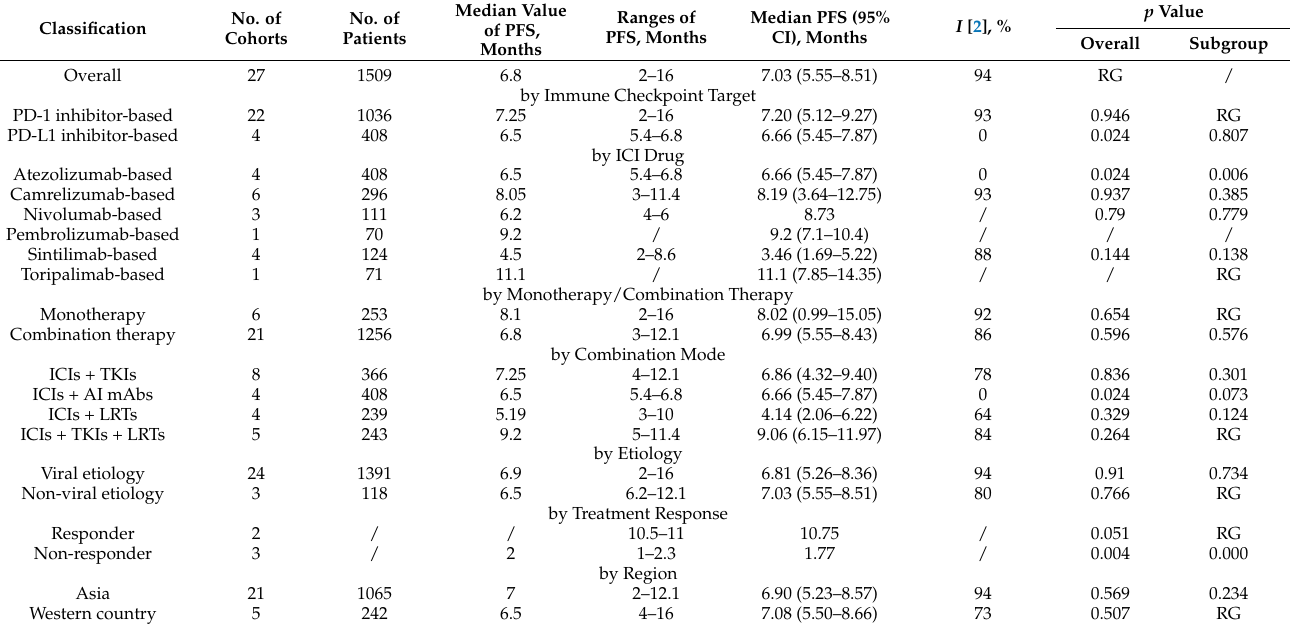
Table 1. Subgroup analysis of PFS in advanced HCC patients receiving first-line ICIs-based